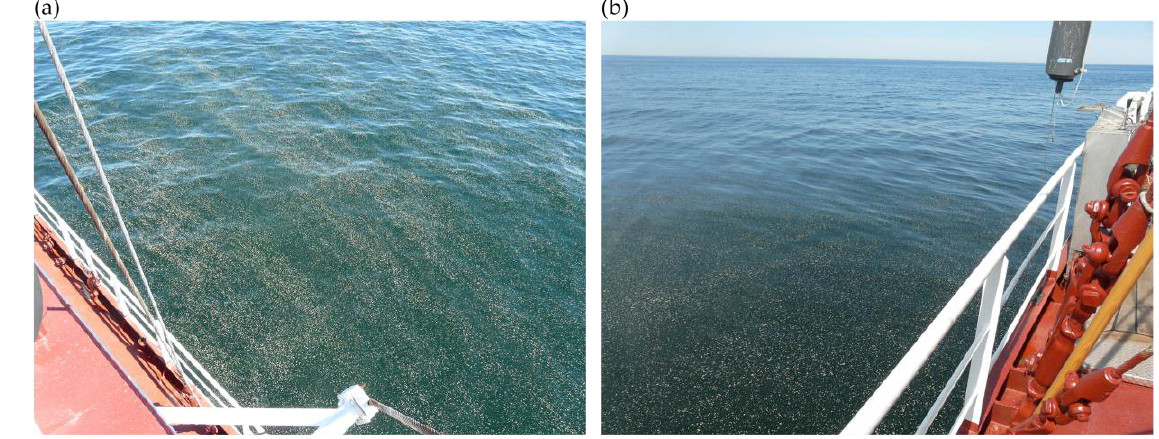
Figure 1. ( a,b ) Floating on the water of the Baltic Sea (from the deck of the ship).